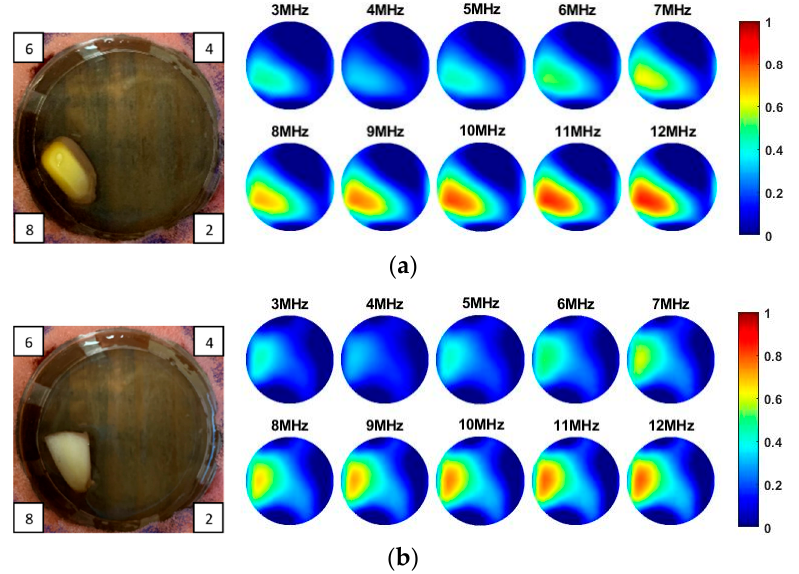
Figure 8. Experimental setup and reconstructed images for ( a ) corn and ( b ) garlic.